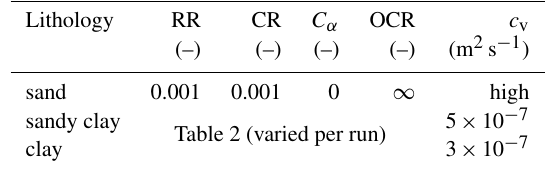
Table 1. Fixed and default parameter values per